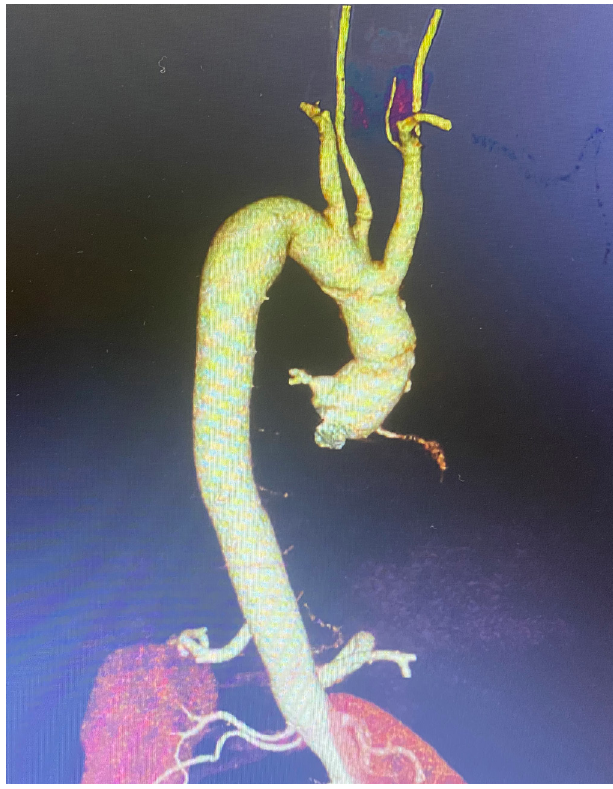
Fig. 2 - Postoperative 3D computed tomography image of the patient after total arch